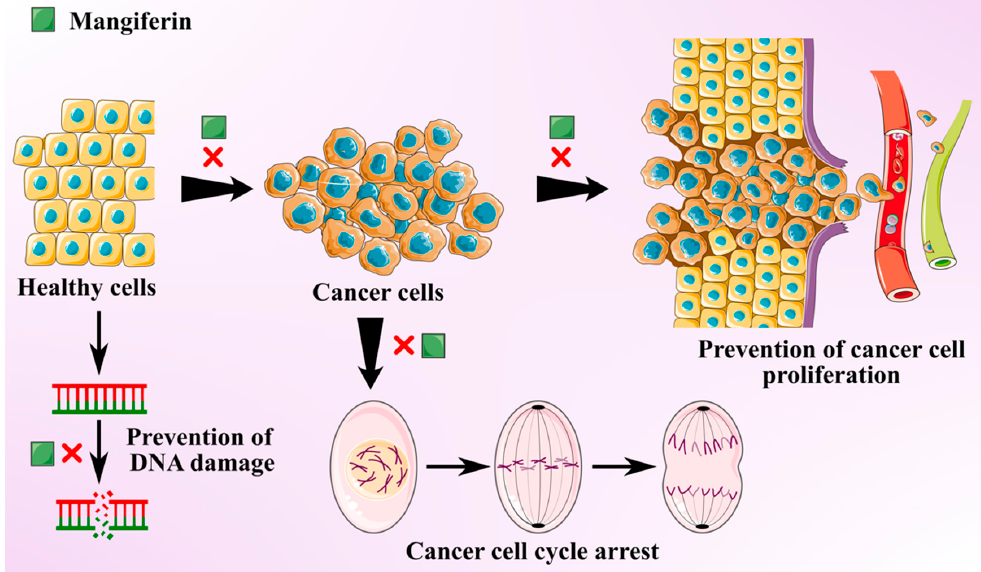
Figure 2. Schematic showing anti-cancer activity of the mangiferin from mango leaves.